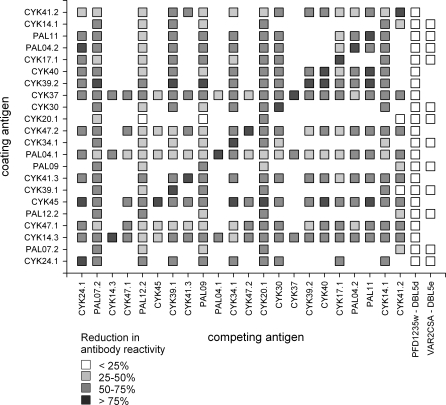
A Matrix Showing the Level of Cross-Reactive Antibody Targets between 22 Placental VAR2CSA DBL3 Variants Produced in Baculovirus-Infected Insect CellsCross-reactivity was determined by competition ELISA using a Tanzanian female plasma pool with a high titer of VAR2CSA-specific antibodies. Responses with the same protein as the competing and coating antigen are shown in the diagonal. Blanks with no square are protein combinations not tested. The identity of the various DBL3 proteins corresponds to the nomenclature used in the published multiple sequence alignment [18]. Control proteins included a DBL5 VAR2CSA protein and a non-VAR2CSA DBL domain (PFD1235w).